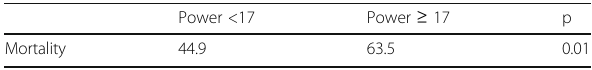
Table 2 (abstract 001529). Mortality and Power